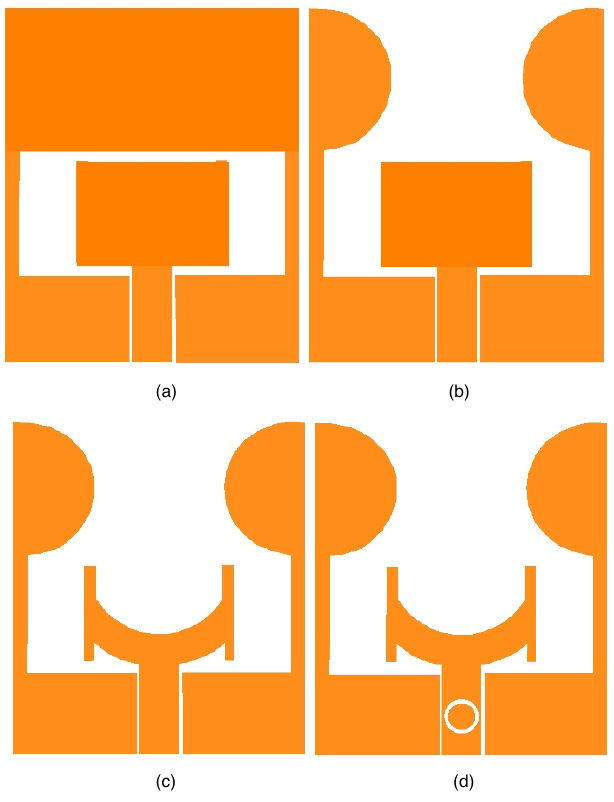
FIGURE 2 . Antenna geometry evolution during the design stages, (a) antenna 1, (b) antenna 2, (c) antenna 3, (d) antenna